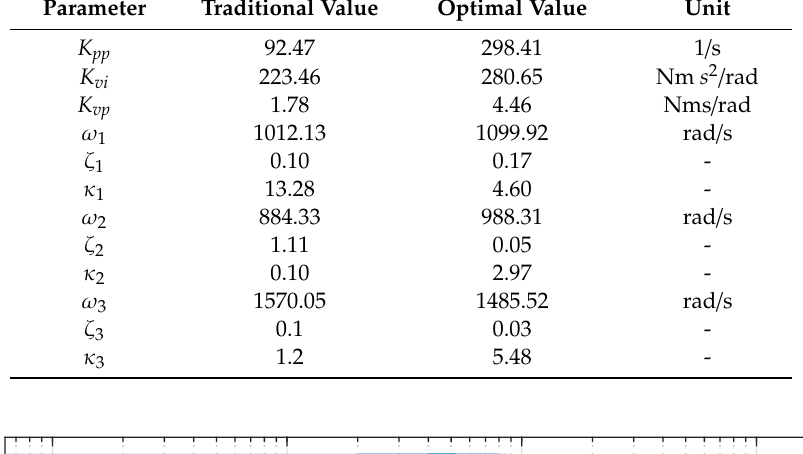
Table 3. The parameter values of optimal and traditional approaches.